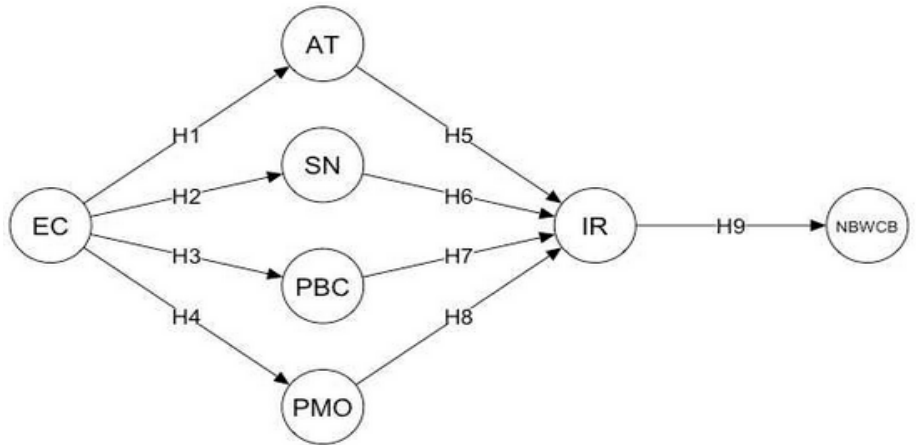
Figure 1. Research model. EC—Environmental concern; AT—Attitude on reducing bottled water consumption; SN—Subjective norms concerning reduction of bottled water consumption; PBC— Perceived behavioural control over bottled water consumption; PMO—Perceived moral obligation to reduce bottled water consumption; IR—Intention to reduce bottled water consumption; NBWCB—Non-bottled water consumption behaviour.